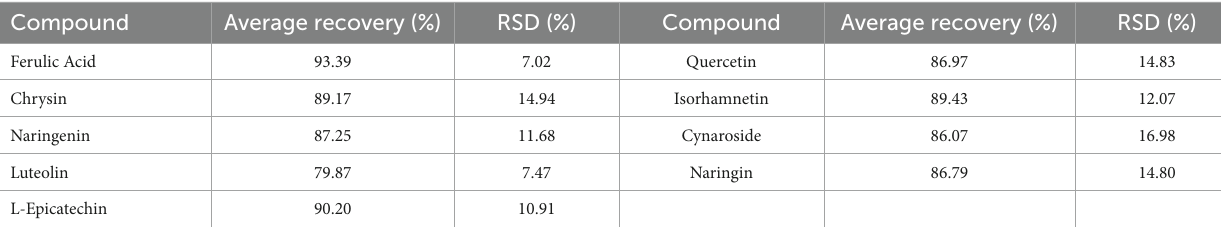
TABLE 4 Results of Dendrobium officinale spiked sample recovery experiment.